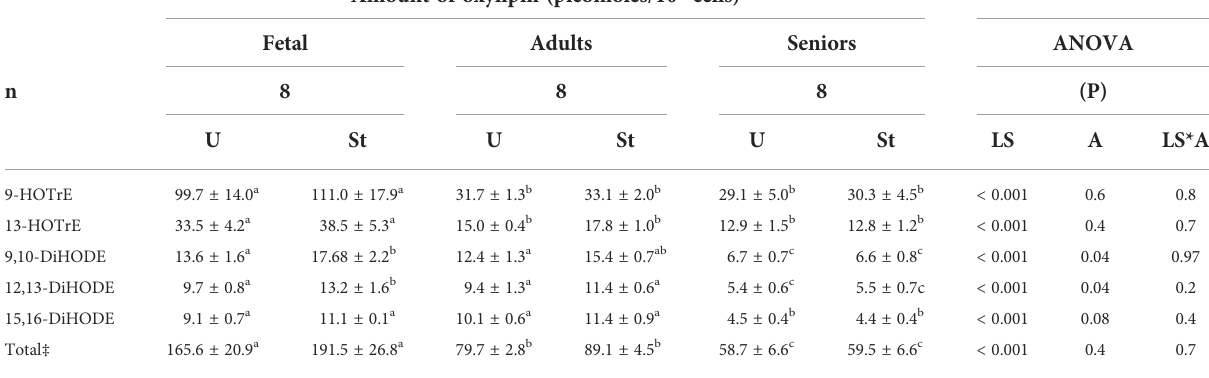
TABLE 3 Amounts of [ 13 C]18: 3 w -3-derived oxylipins in unstimulated and mitogen-stimulated T lymphocytes. Amount of oxylipin (picomoles/10 6